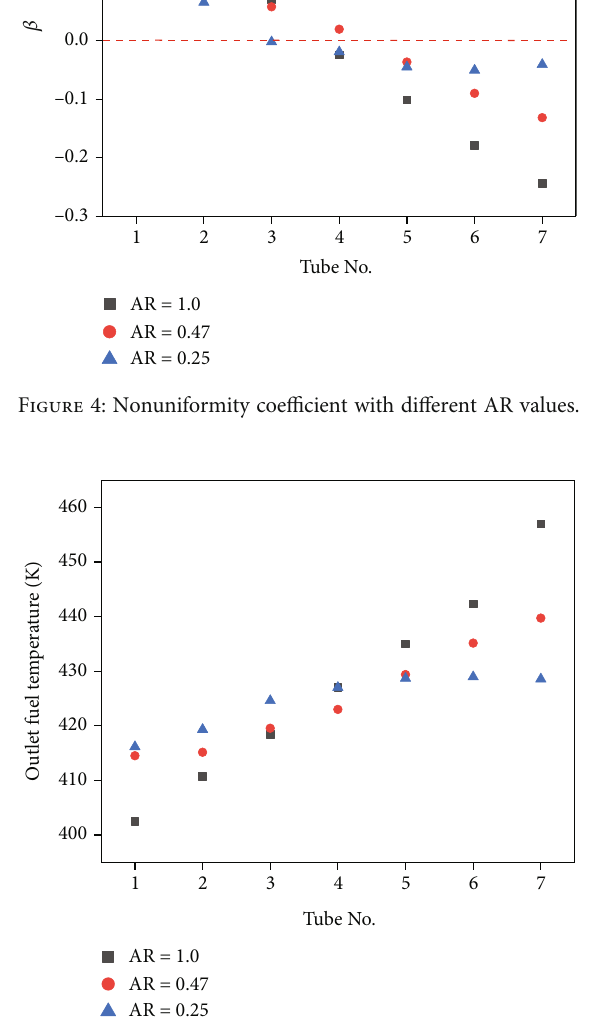
Figure 3: Grid independence study.